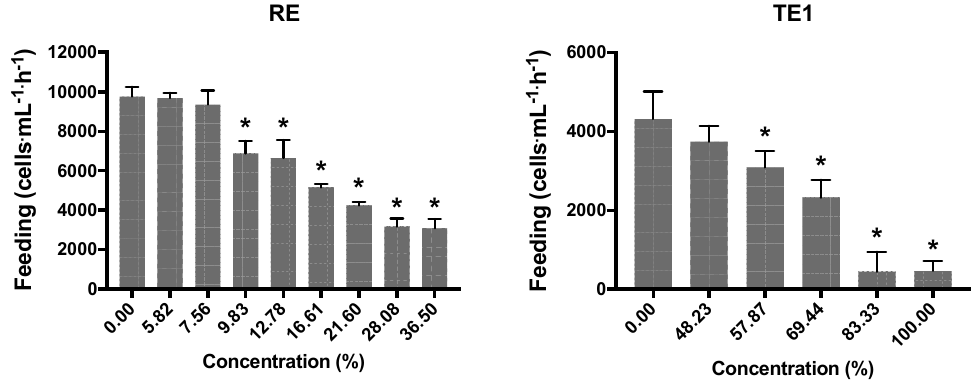
Figure 3. Average feeding rate (cells∙mL −1 ∙h −1 ) of D. magna after exposure to different concentrations of raw effluent (RE) or treated effluent 1 (TE1) compared to the control. Error bars represent the standard deviation of the mean (n = 4); asterisks indicate statistically significant differences from the control (Dunnett´s test p < 0.05).